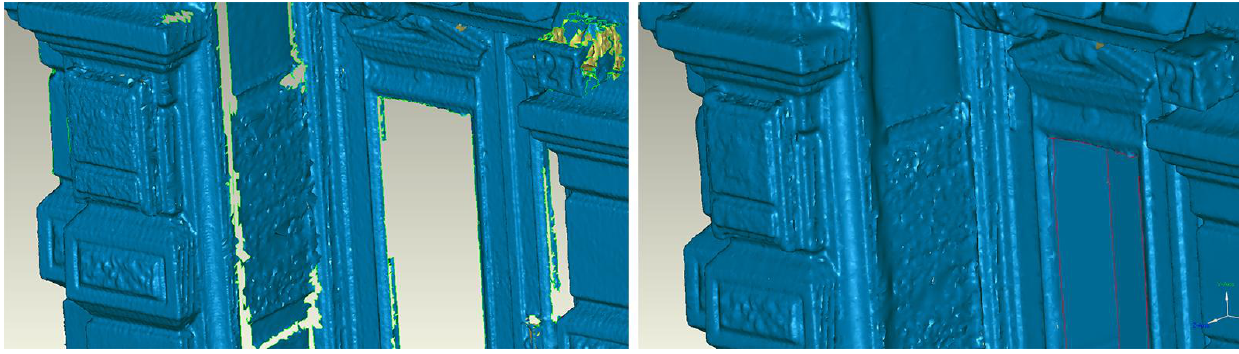
Figure 4. A segment of the mesh before and after decimation and filling